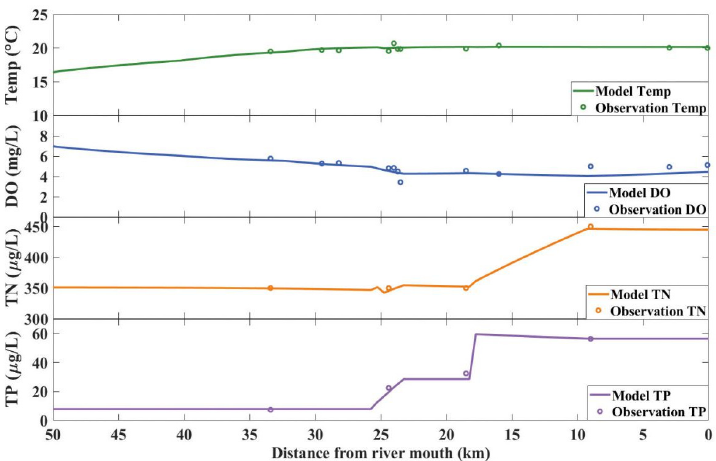
Figure 3. Model annual average water temperature and DO/TN/TP concentrations along the Shoalhaven River in 2017 compared with observations (model